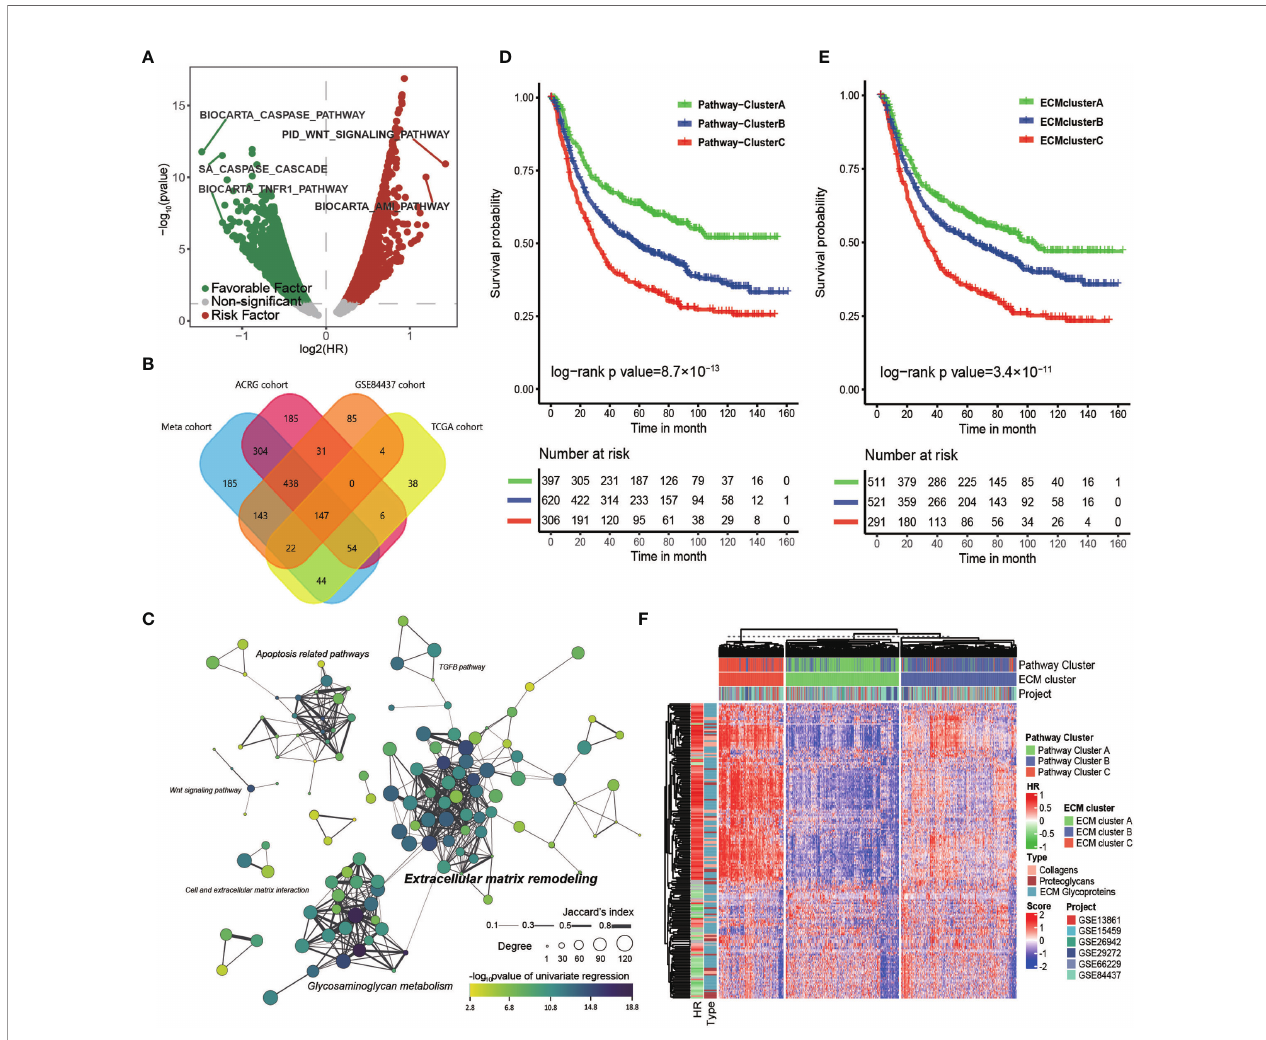
FIGURE 1 | The core matrisome is major pathway involved in gastric cancer progression. (A) Volcano plot of prognostic pathways. The x-axis shows the log2 transformed hazard ratio and the y-axis shows − log10 transformed log rank p-values. Red dots indicate risk pathways; green dots indicate favorable pathways; and Grey dots indicate non-prognostic pathways. (B) Venn plot of the prognostic pathways in the TCGA-STAD cohort, ACRG cohort, GSE84437 cohort, and the meta- cohort. (C) Network of prognostic pathways in the meta-cohort. Each dot represents a prognostic pathway in gastric cancer. A line connecting two pathways means the Jaccard ’ s index between gene sets of the two pathways. The size of the dot represents the degree of the pathway in correlation network of these pathways. The color fi lling the dot shows the − log10 transformed p-value of univariate cox regression for the GSVA score of the corresponding gene set. (D) Kaplan – Meier curves for the overall survival of 1323 patients in the meta-cohort with 3 distinct pathway clusters. The sample size of pathway clusters A, B, and C were n = 397, n = 620, and n = 306, respectively. Log-rank test, p -value = 8.7 × 10 − 13 . (E) Kaplan – Meier curves for overall survival of 1323 patients in the meta-cohort with 3 distinct ECM clusters. The sample size of ECM clusters A, B, and C were n = 511, n = 521, and n = 291, respectively. Log-rank test, p-value = 3.4 × 10 − 11 . (F) Heat map showing the unsupervised clustering of 274 types of ECM for 1323 patients in the meta-cohort. The ECM clustering resembled the pathway clustering to a great extent. The hazard ratio and subtypes of ECM in the meta cohort are also shown in annotation on the